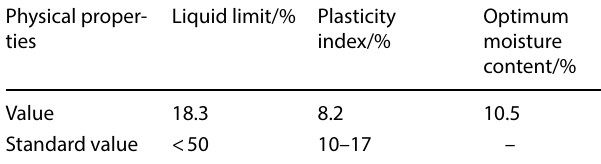
Table 6 Physical properties of the silty clay Physical proper-